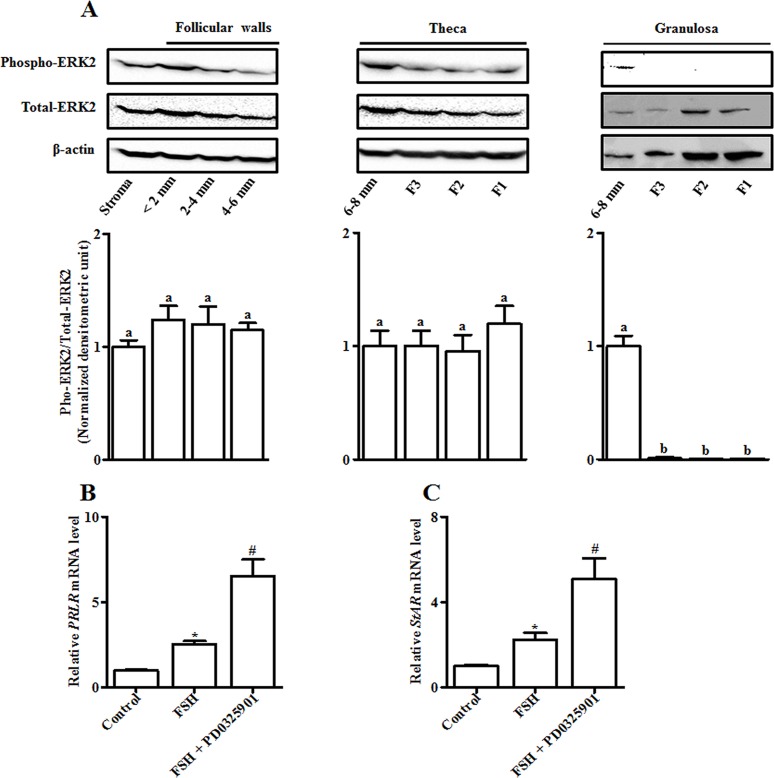
Abundance of ERK2 protein in chicken developing follicles and its role in FSH-induced PRLR and StAR expression in cultured granulosa cells of 6–8 mm follicles.(A) Top panel: Representative western blot analysis of phosphorylated and total ERK2 in the stroma and walls of prehierarchical (< 2, 2–4 and 4–6 mm) follicles as well as in theca and granulosa cell layers separated from the 6–8 mm and F3-F1 follicles. β-actin was used as loading control. Bottom panel: Quantitative analysis of relative protein abundance of phosphorylated ERK2 by densitometry using Image Lab software (Version 4.1, Bio-Rad laboratories). Relative protein abundance was normalized to total ERK2. Data are expressed as fold differences ± SEM compared to an appropriate tissue (n = 4 hens). Bars with different letters are significantly different at P < 0.05. (B and C) Changes in relative mRNAs levels of PRLR (B) and StAR (C) in granulosa cells treated without or with 10 ng/ml FSH, or together with the MEK inhibitor (1 μM PD0325901) after a 4-h culture. Relative mRNA expression level was normalized to 18S rRNA. Data are expressed as fold differences ± SEM of three independent experiments using tissues from different hens and are compared to control cells. *, P < 0.05 compared to control cells; #, P < 0.05 compared to cells only stimulated by 10 ng/ml FSH.